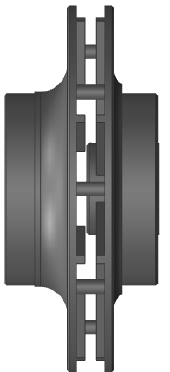
Table 1. Literatures related to the Tesla bladed pump.